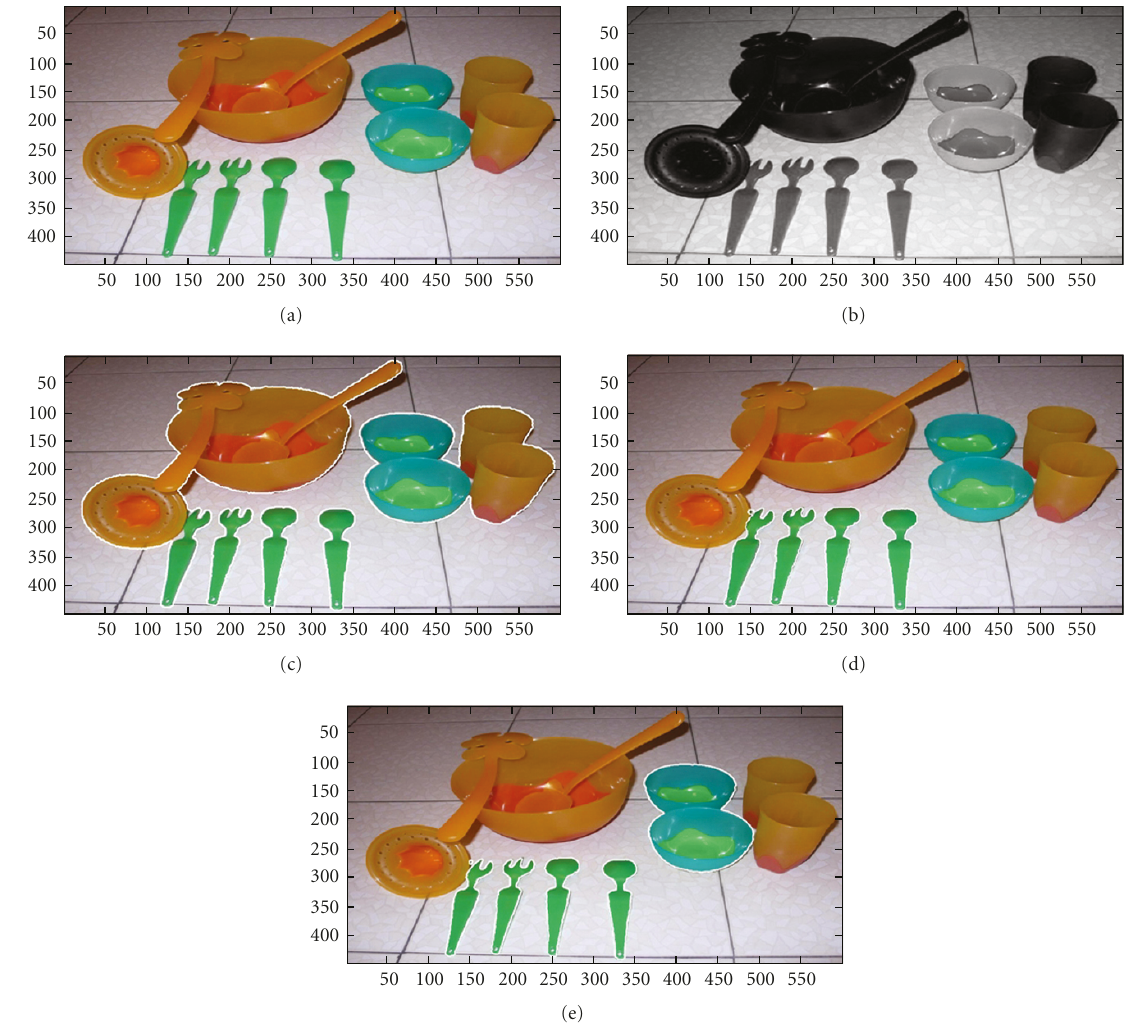
Figure 7: (a) Original RGB image. (b) Blue channel of original RGB image and segmentation results by (c) level set model, (d) threshold level set model, and (e) adaptive multi-threshold level set